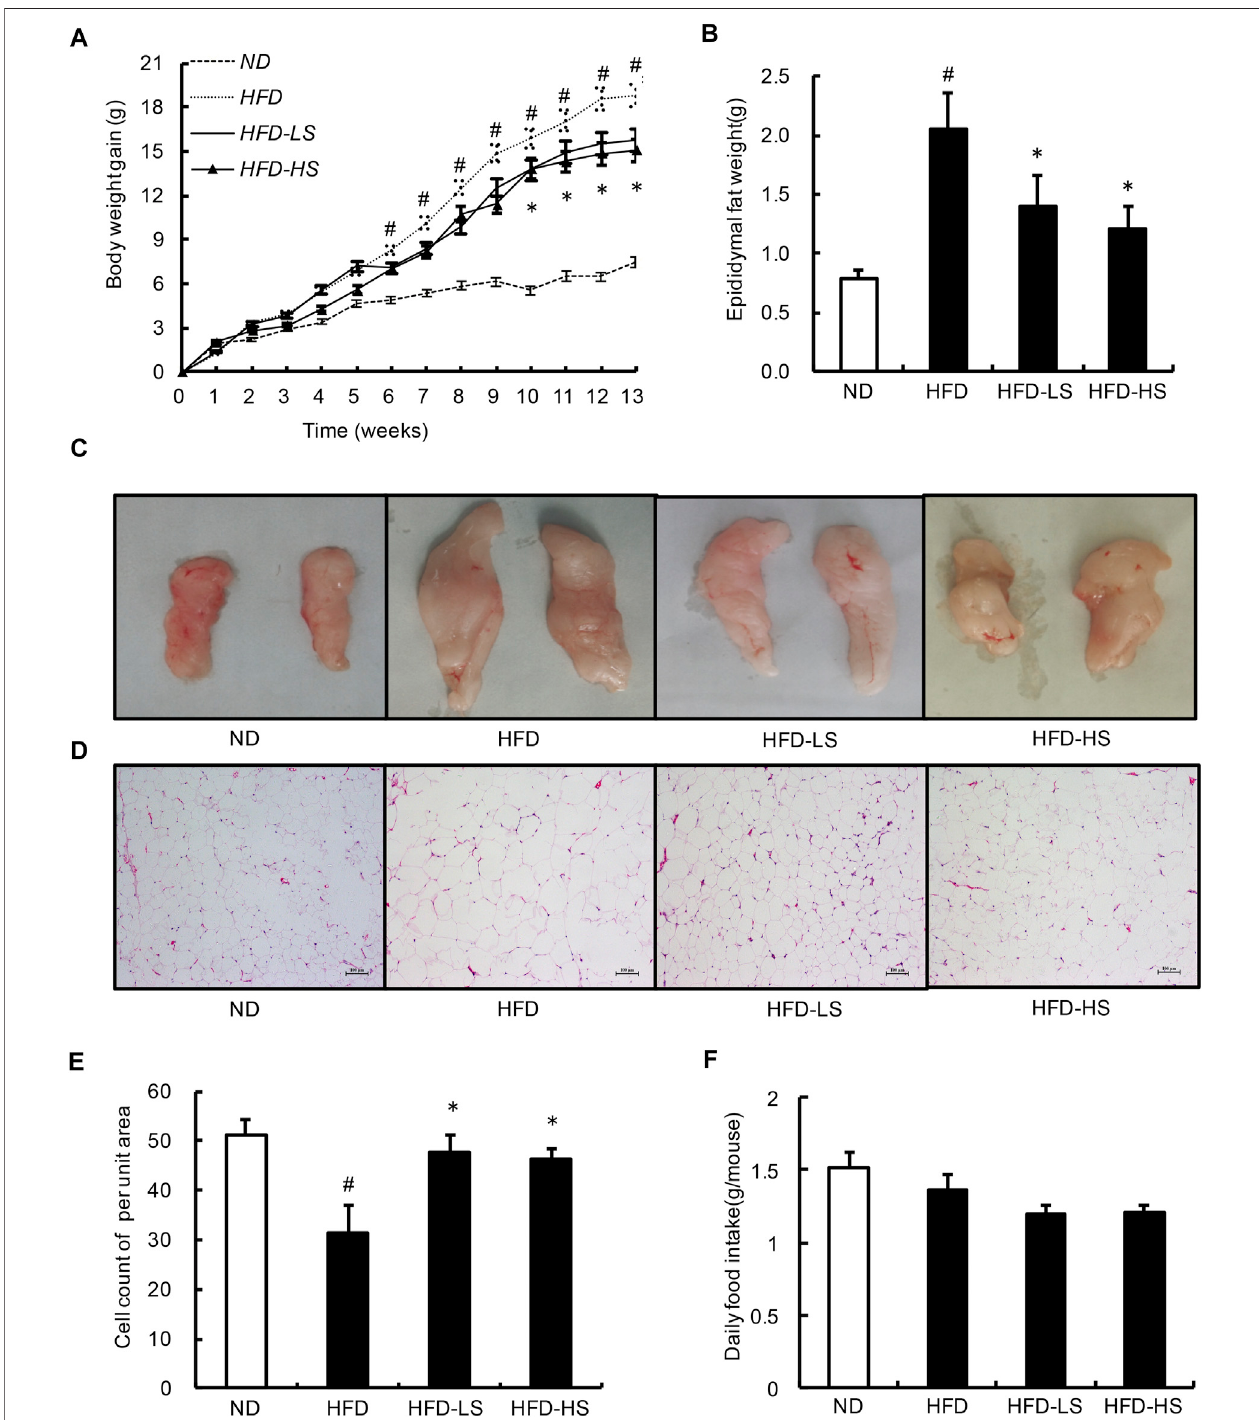
FIGURE 4 | Sal A lowered body weight gain and decreased the eWAT mass and the size of adipocytes within eWAT. (A) Change in body weight gain. and (B) the eWATmass. (C) Morphologicalphotographs ofepididymal fat. (D) H&EstainingofeWATtoobserve thesizeofadipocytes,scalebar (cid:1) 100 μ m;and (E) thecellcountof per unit area in H&E-stained sections. (F) The daily food intake. # re fl ects comparing with normal diet (ND) group; * re fl ects comparing with high-fat diet (HFD) group. All groups contain 12 animals ( n (cid:1) 12).